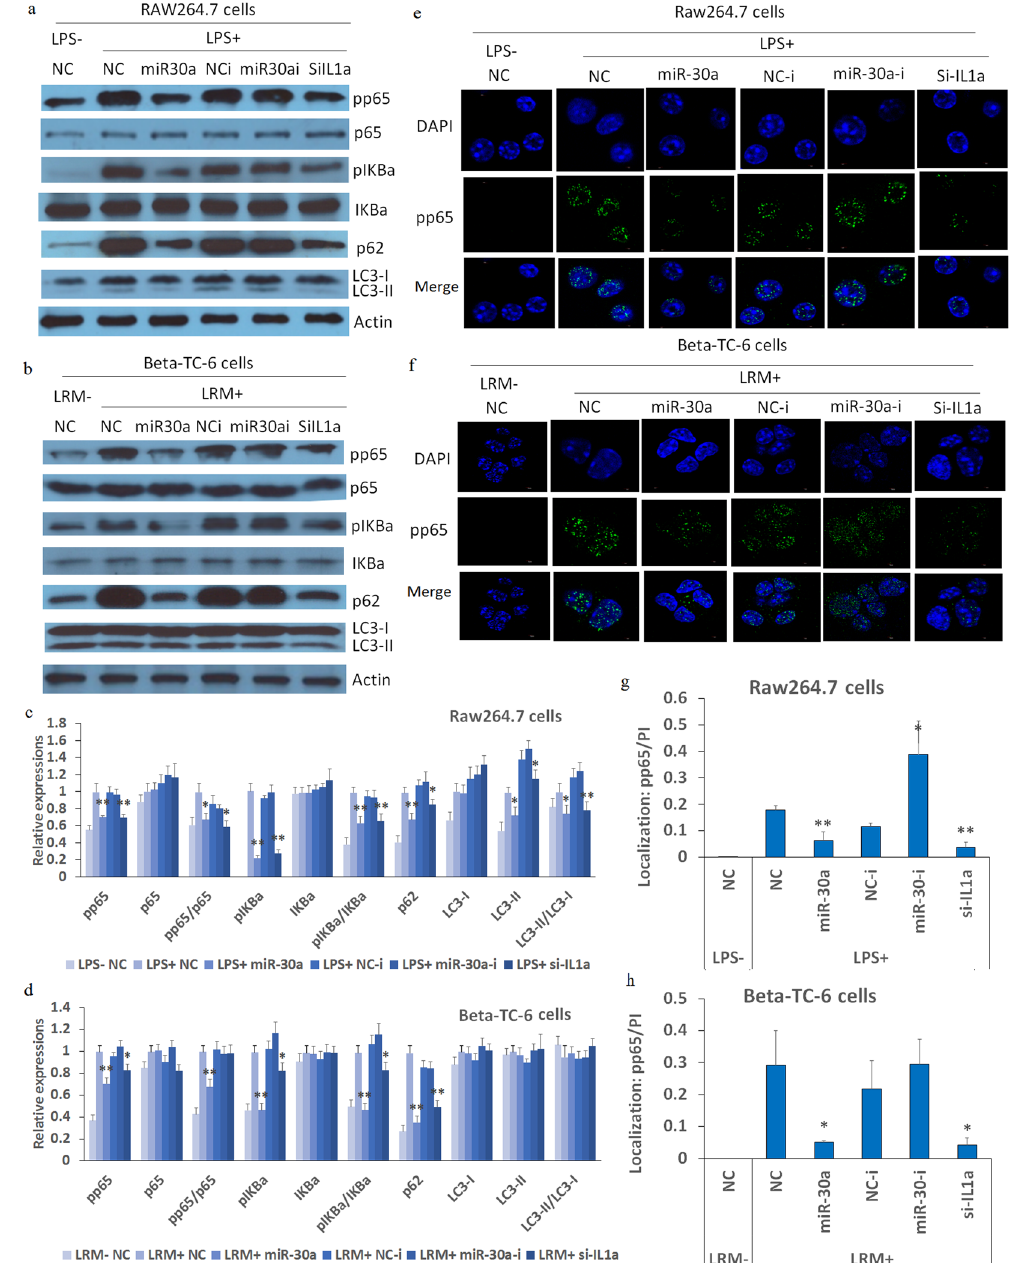
Figure 5. Effects of miR-30a mimics on inflammatory and autophagy factors and NFKB activity in RAW264.7 and Beta-TC-6 cells subjected to inflammatory stimulation. ( a and b ) Western blotting showing that miR-30a mimics significantly inhibit the increases of pp65, pIKBa and p62 in RAW264.7 and Beta-TC-6 cells after 24 h of LPS and LRM, respectively (the uncropped images are available in Supplementary Fig. S3); ( c and d ) the relative expression was calculated by the ratios of gray density values of protein bands to actin. ( e – h ) IF and confocal assays showing that miR-30a mimics significantly inhibited pp65 translocation into the nucleus in RAW264.7 and Beta-TC-6 cells after 24 h of LPS and LRM induction, respectively. The gray density values of fluorescence proteins and DAPI were calculated by ImageJ software, and these protein levels in cells were normalized with DAPI (PI). Approximately 100 cells in each slide (3 slides per group) were randomly selected and the average value in each slide was obtained for further statistical analysis. LRM + / − , incubation with or without LRM; NC, negative controls of miRNA mimics; NC-i, negative controls of miRNA inhibitors or siRNA; miR-30a-i, miRNA-30a inhibitor; and si-IL1a, silencing mRNA fragment of Il-1a. Data are expressed as the Mean ± SD (n = 3); * P < 0.05 and ** P < 0.01 vs. NC or NC-i (LPS/LRM + ),